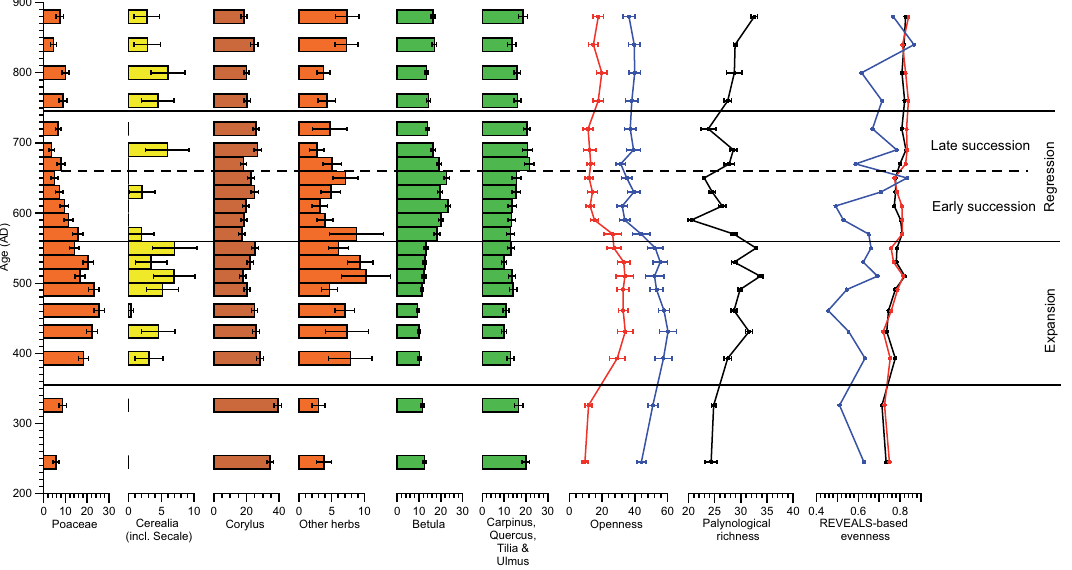
Fig. 5. Regional vegetation cover for selected taxa/taxa groups, openness, palynological richness and REVEALS-based evenness at the transition from expansion to regression AD350 to 750. Openness was estimated both including and excluding shrubs ( Juniperus and Corylus ) shown by blue and red lines, respectively. REVEALS-based evenness was calculated for all 26 reconstructed taxa (black line), but also for trees (red line) and herbs (blue line) separately. The transition was divided into one expansion and two regression